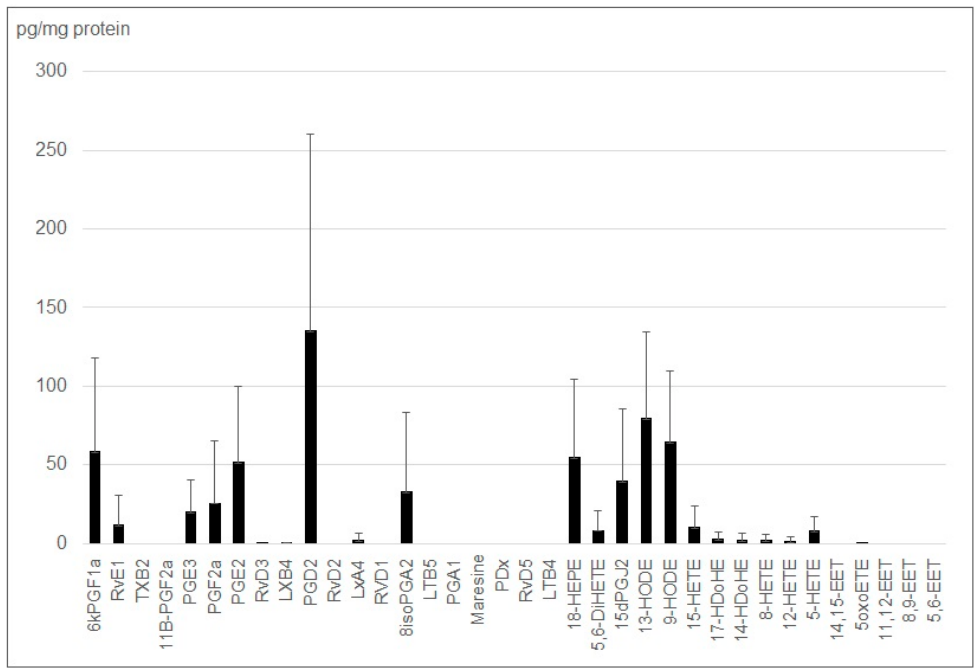
Figure 4. Lipid mediators’ profile from small EVs obtained from deprived J774 cell cultures in triplicate.